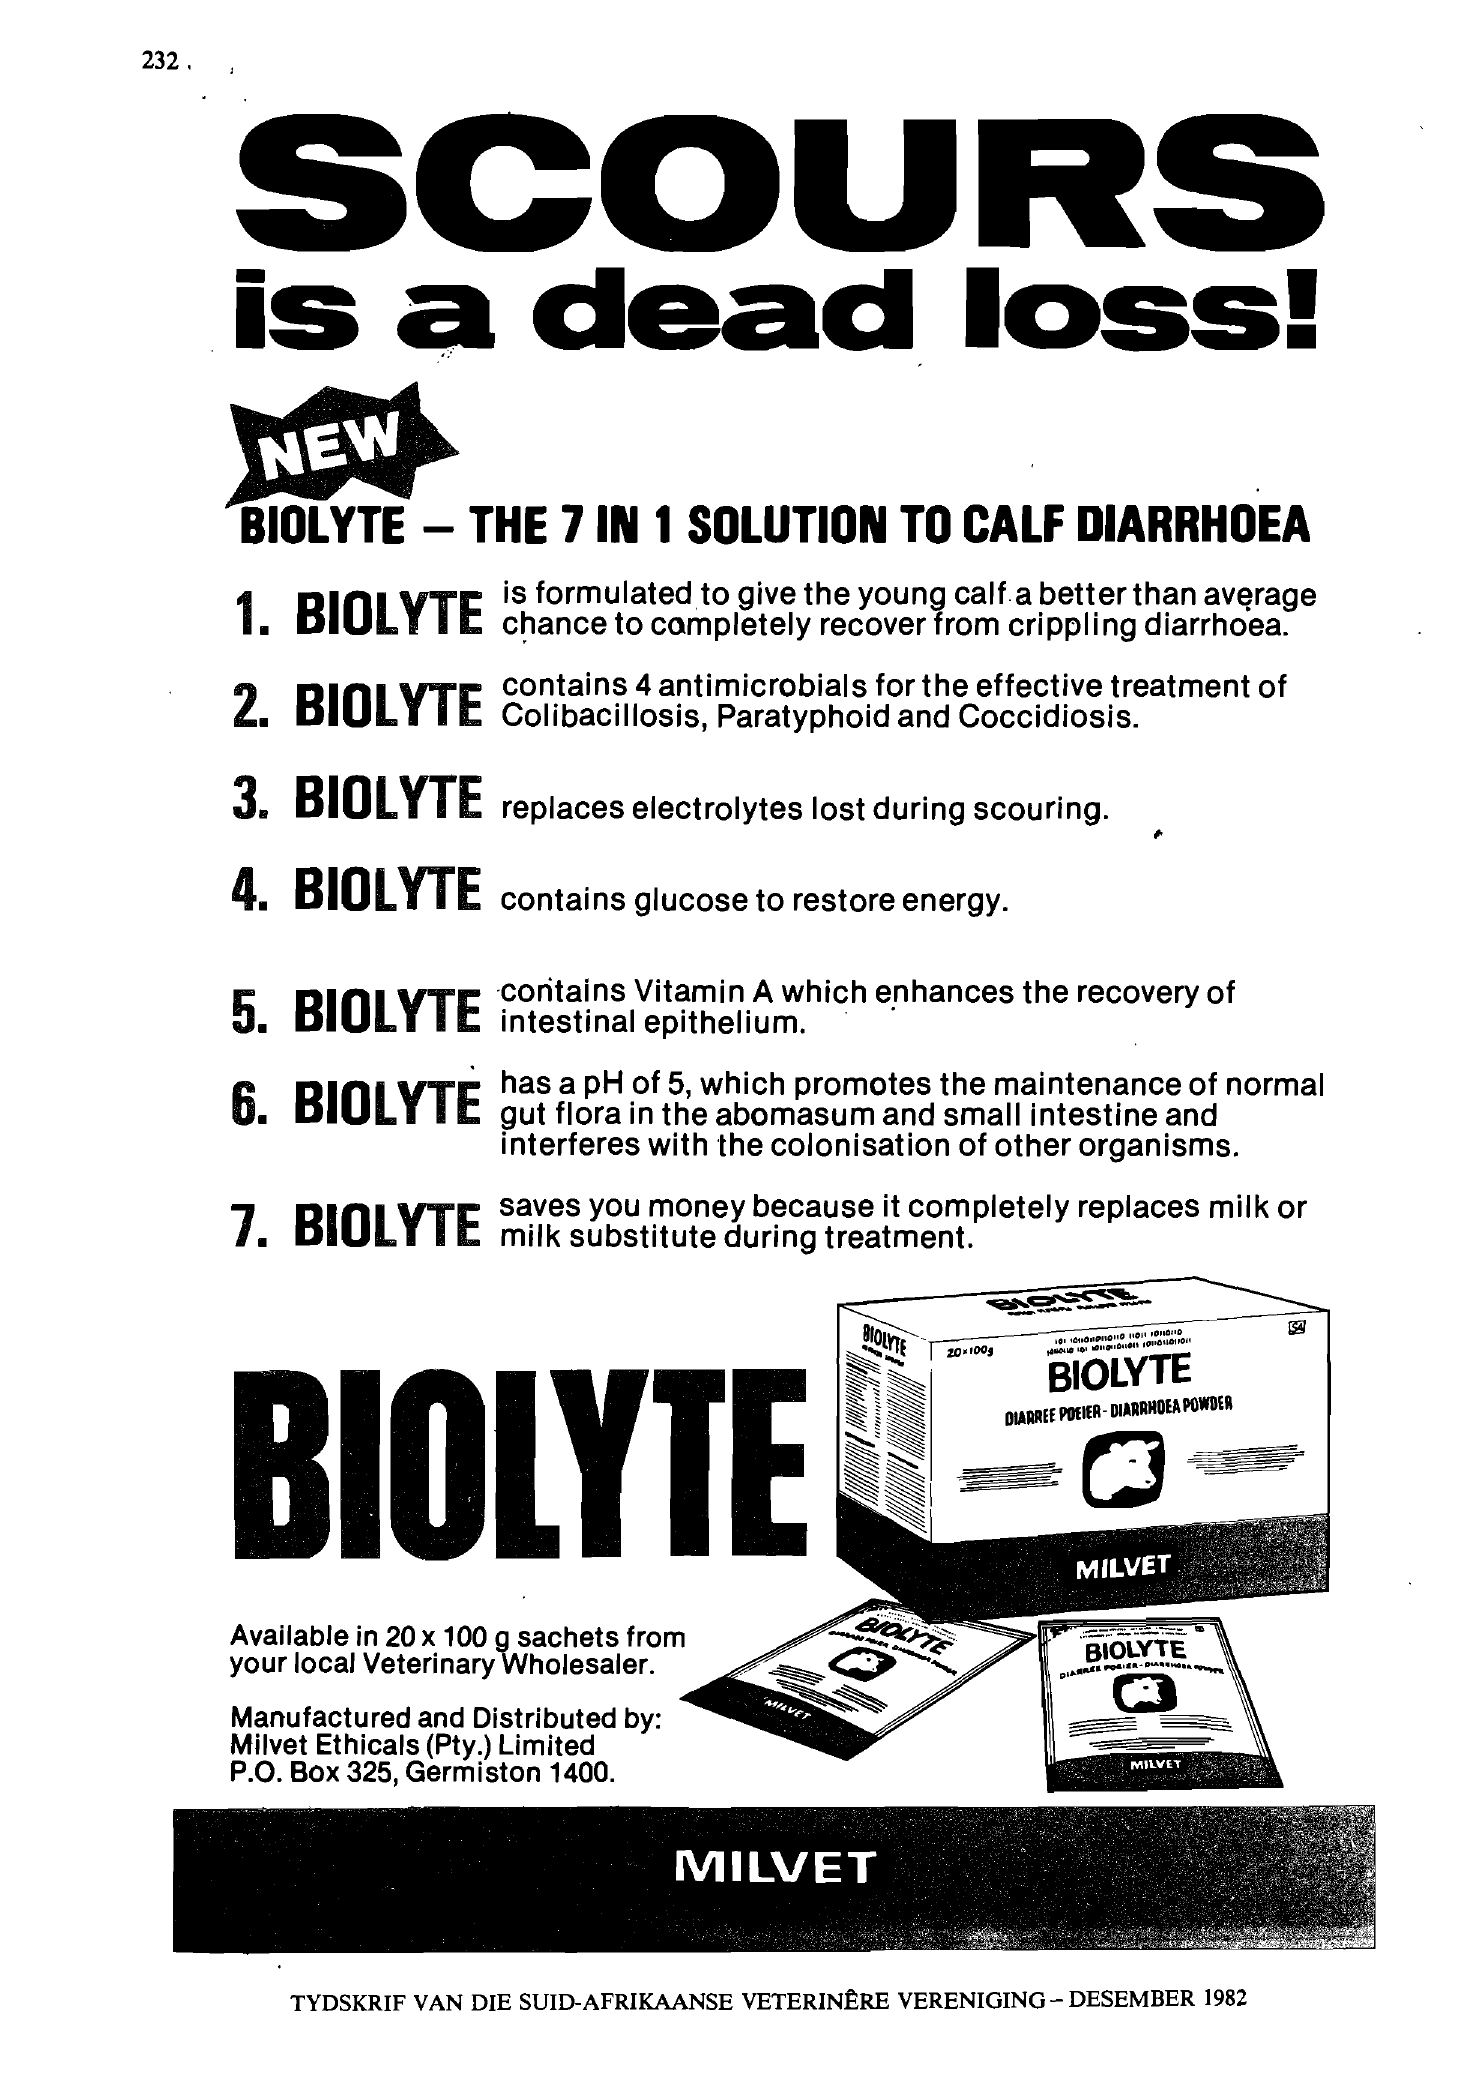
THE 7 IN 1 SOLUTION TO CALF DIARRHOEA BIOLYTE is formulatedto give the young calfa better than av~rage contains 4 antimicrobials for the effective treatment of Colibacillosis, Paratyphoid and Coccidiosis. replaces electrolytes lost during